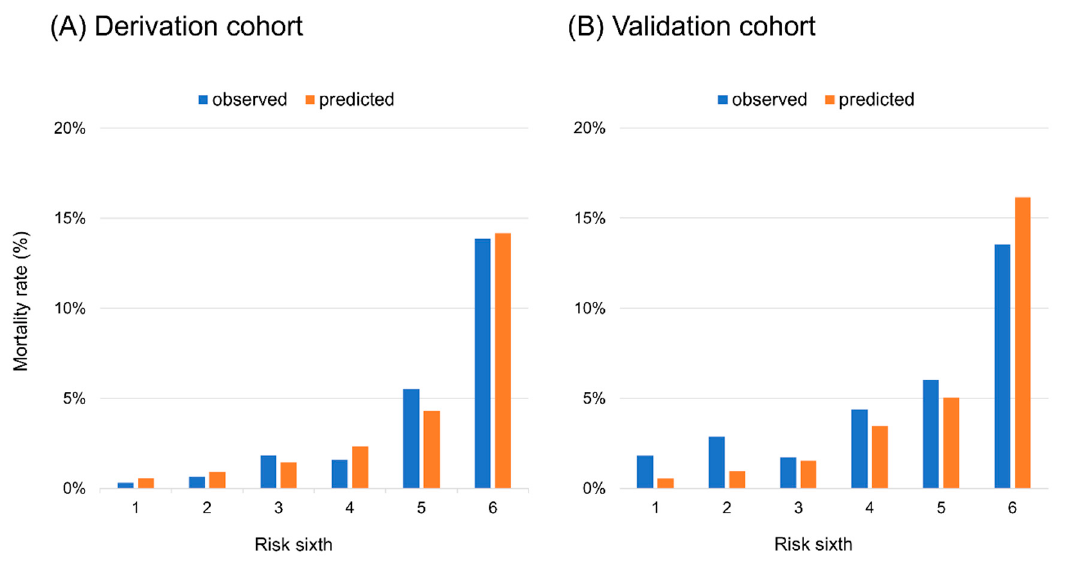
Figure 1. Calibration plots for the model applied to the ( A ) derivation cohort and ( B ) validation cohort.